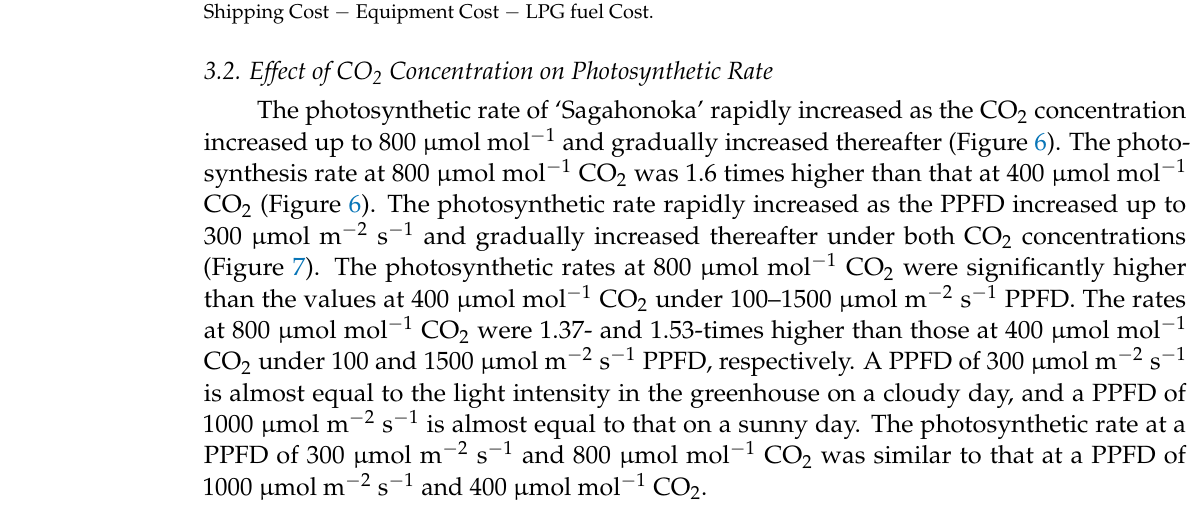
Figure 7. The relationship PPFD and photosynthetic rate of strawberry ‘Sagahonoka’. ** is signifi- cantly different at 1% level by t -test. Error bar means standard error ( n = 4). The measurement con- ditions are leaf temperature 20 °C, relative humidity 70%. 3.3. Effect of CO 2 Concentration on Translocation and Distribution Rate of 13 CO 2 - Photoassimilates The dry matter weight of each part was compared under the conditions of 400 and 800 μmol mol −1 CO 2 in the growth chamber (Table 3). The dry matter weight of the primary fruit at 800 μmol mol −1 CO 2 was significantly higher than that at 400 μmol mol −1 CO 2 24 days after the flowering of secondary inflorescence. In addition, the dry matter weight of the aerial part at 24 days after flowering was higher than that at the flowering time and 12 days after flowering, and the 800 μmol mol −1 CO 2 treatment resulted in a higher dry weight of the aerial part compared to 400 μmol mol −1 CO 2 at 24 days after flowering. The translocation rates for 13 CO 2 -photoassimilates at 24 days after flowering were 20% higher than those at the flowering time and 12 days after flowering, but they were not affected by the CO 2 concentration. The rate of distribution to fruits increased as the number of days after flowering increased, and it was about 30% at 12 days after flowering, becoming 90% or more at 24 days after flowering (Figure 8). The rate of the distribution of the primary fruit was higher under 800 μmol mol −1 CO 2 than 400 μmol mol −1 CO 2 at 12 and 24 days after flowering.